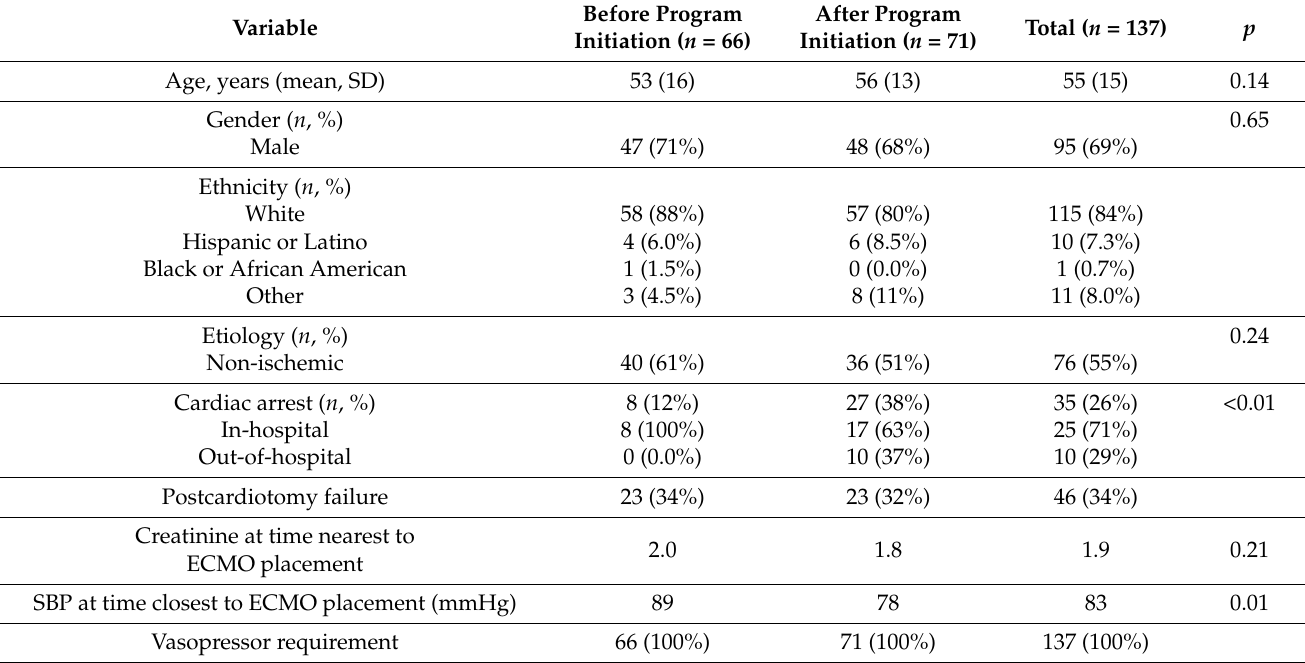
Table 1. Patient demographics and ECMO data pre- and post-portable program